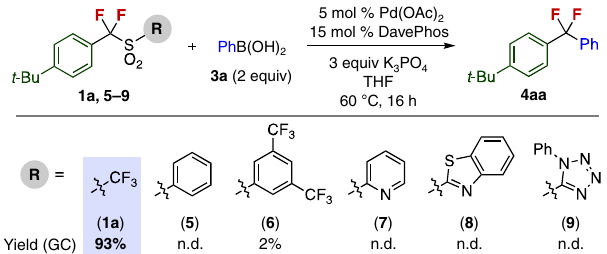
Fig. 2 Substituent effect of sulfonyl group on desulfonylative cross-coupling reaction. Reactions were carried out on a 0.1 mmol scale. Yields